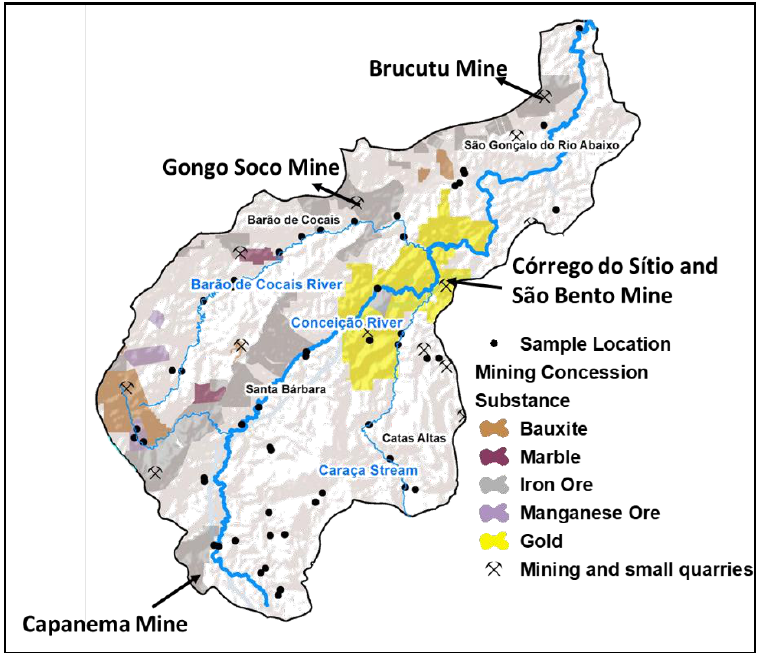
Figure 2. Location of mining concession areas for bauxite, marble, iron, manganese, and gold [22], and main mining activities of the Conceição river basin.